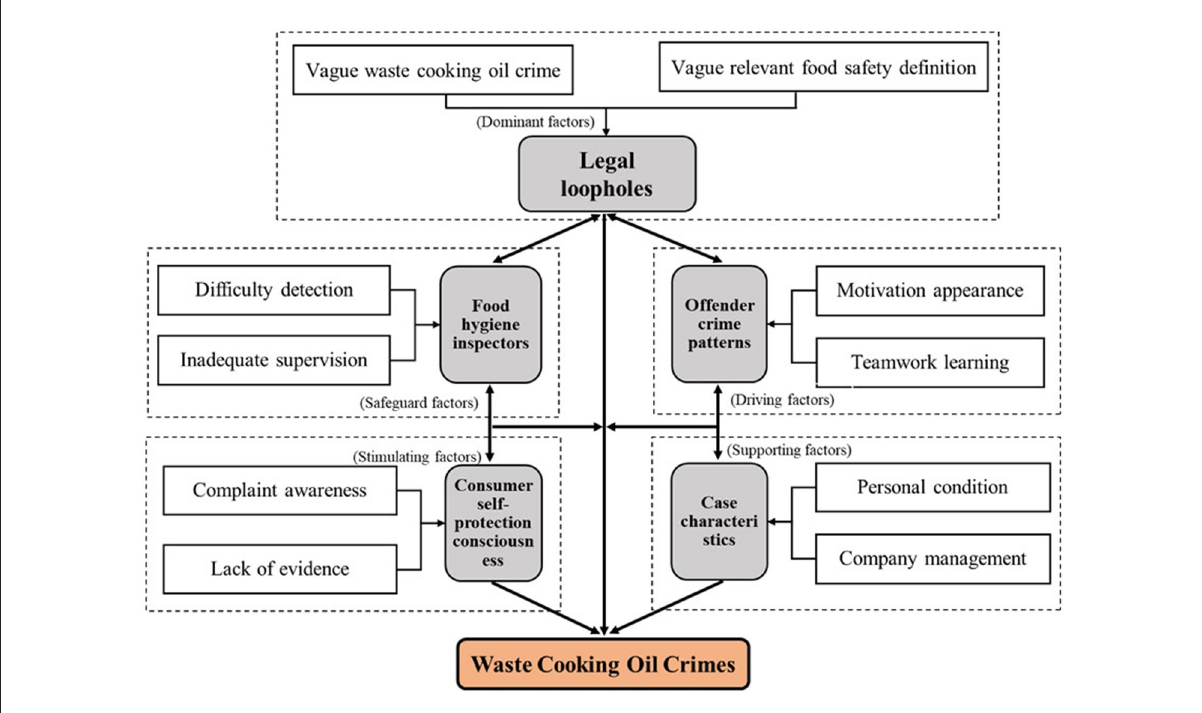
FIGURE5 Determinants and mechanisms of the WCO